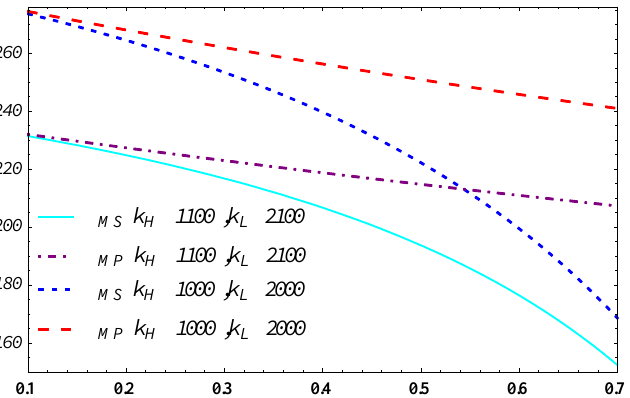
Figure 3. Influence of θ on the high-efficiency manufacturer of carbon reduction.